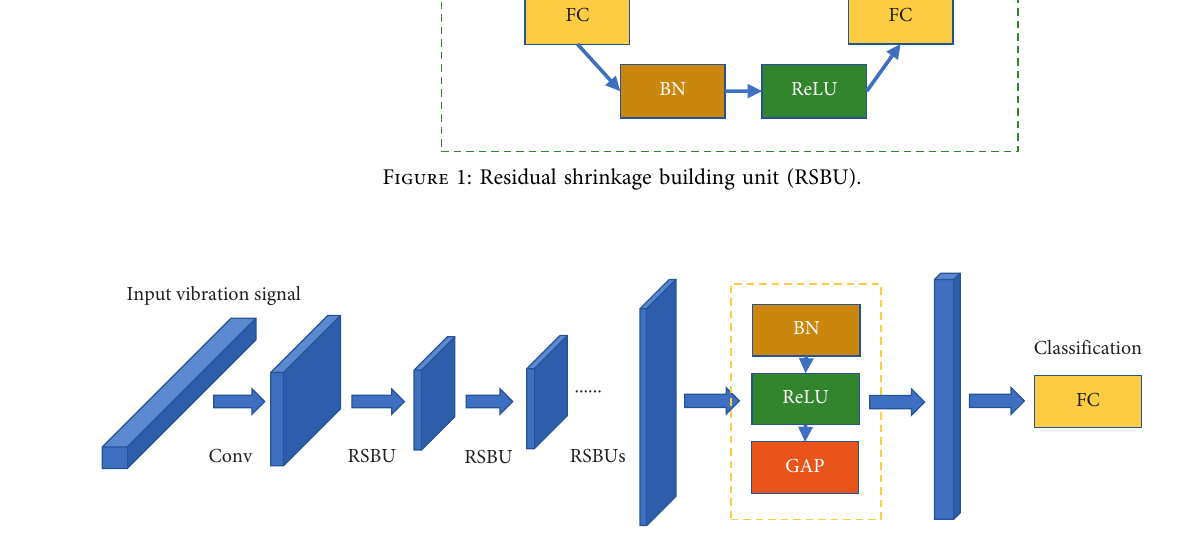
Figure 2: Structure of the